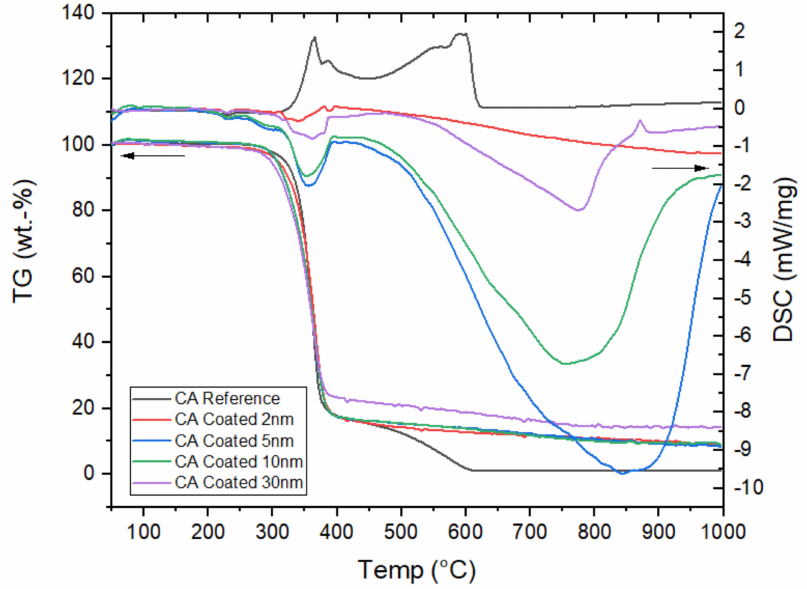
Figure 16. TGA and DSC curves of CA fibres with variable amounts of coated Al 2 O 3